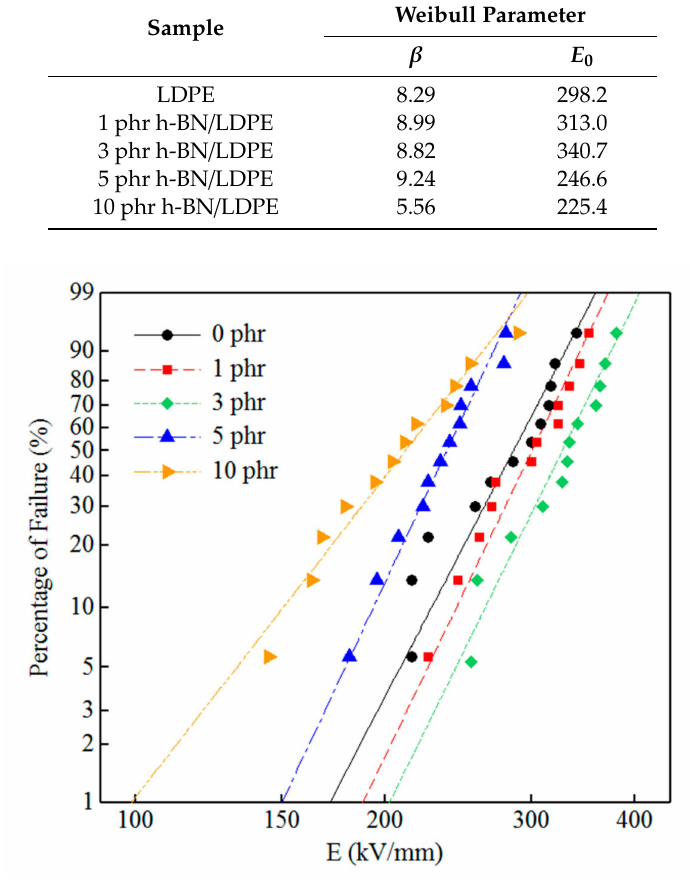
Table 1. Breakdown strength and Weibull distribution parameters of each sample.